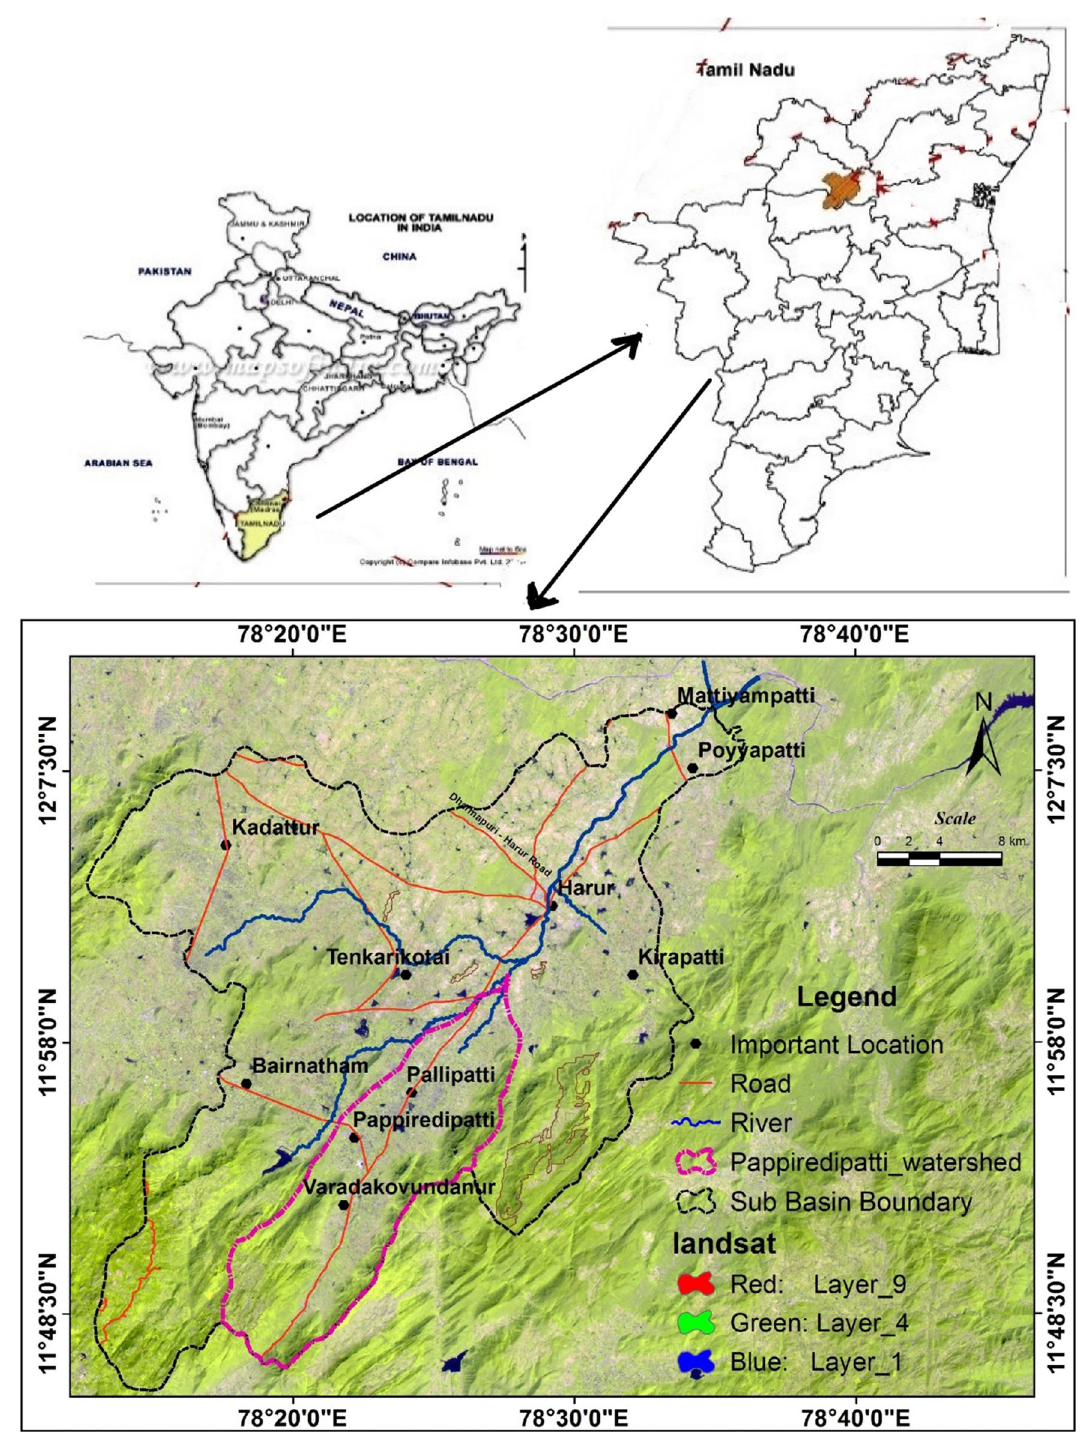
Fig. 1 Location of the study